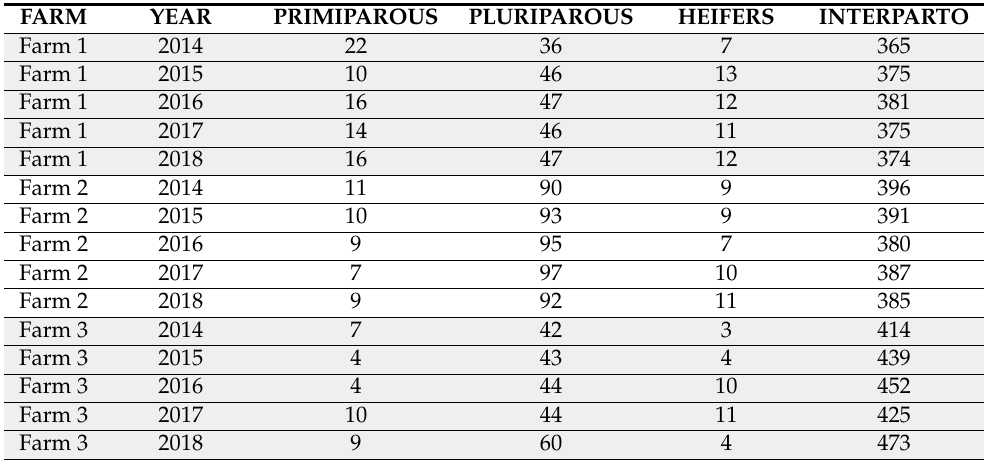
Table 1. Standard Data Panel. Structure of the dataset. The farms are listed horizontally, as well as the reference year, the variables